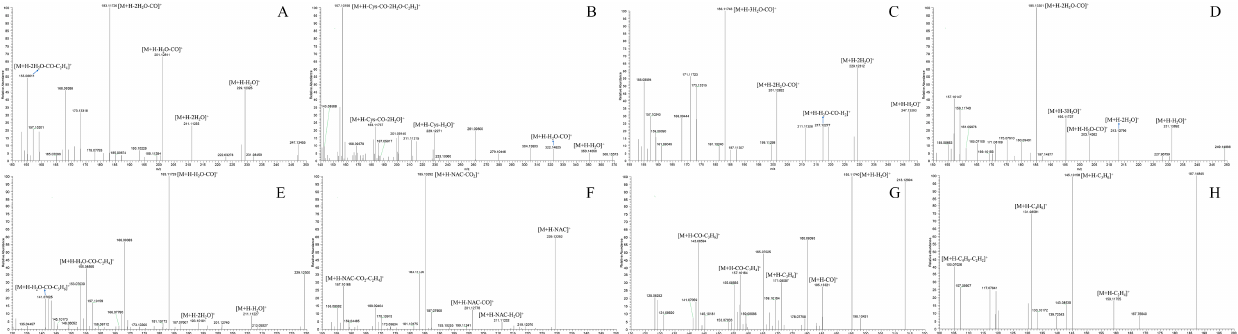
Figure 6. The ESI–MS 2 spectra of eight typical metabolites: ( A ) M11; ( B ) M12; ( C ) M16; ( D ) M26; ( E ) M33; ( F ) M36; ( G ) M54; ( H ) M68.